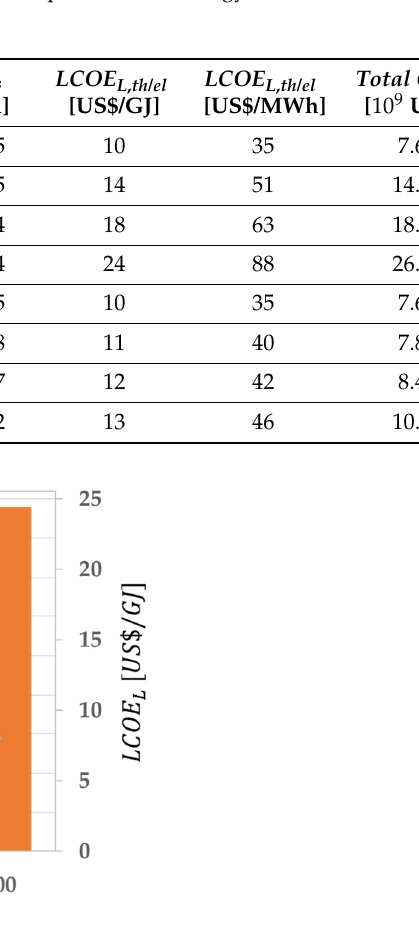
Figure 7. The LCOE as a function of the renewable share targets X RES for the case in which the excess electrical energy is utilized or exported (to the grid). The LCOE values are compared with a reference natural gas cost in Australia in 2021 of USD 8/GJ [40] and the USD 2/kg target for hydrogen production [41].